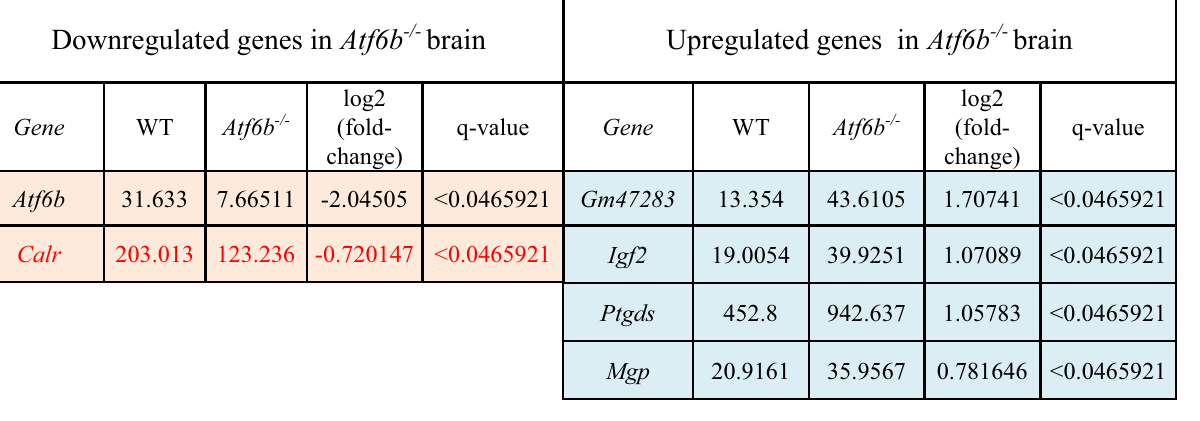
Table 1. Differentially expressed genes in Atf6b −/– brain (q < 0.05). Pink and blue colors indicate Upregulated- genes and downregulated-genes in Atf6b −/−